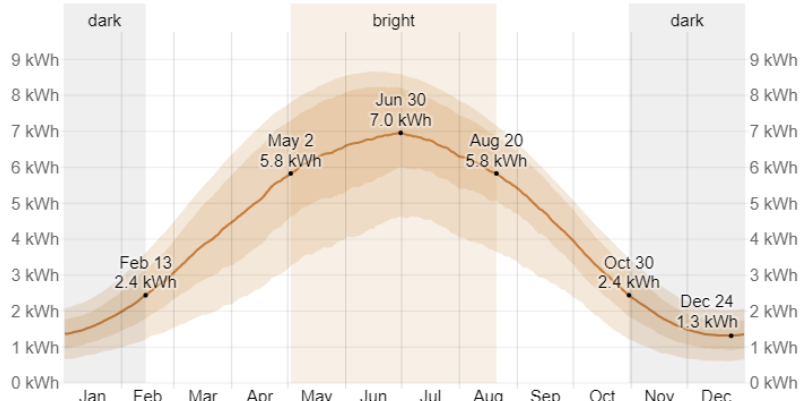
Figure 2. Hours of daylight and twilight in Toronto, Canada [33].